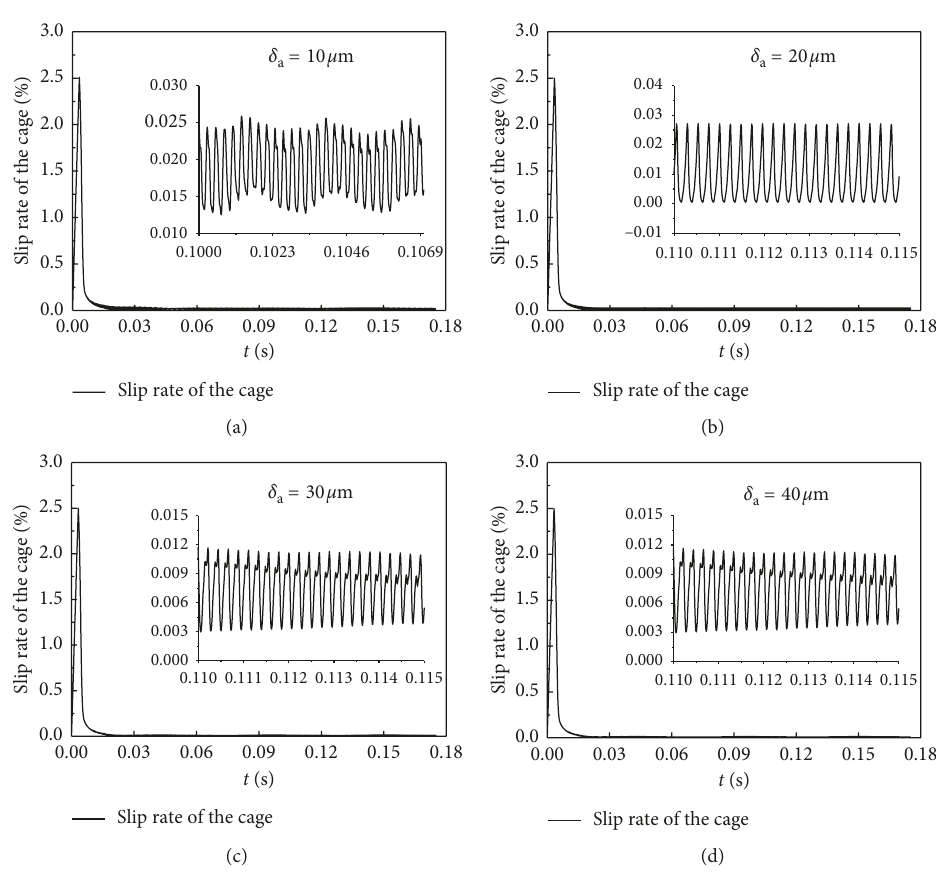
� 0; δ � 10 ∼ 40 μ m; ω r a